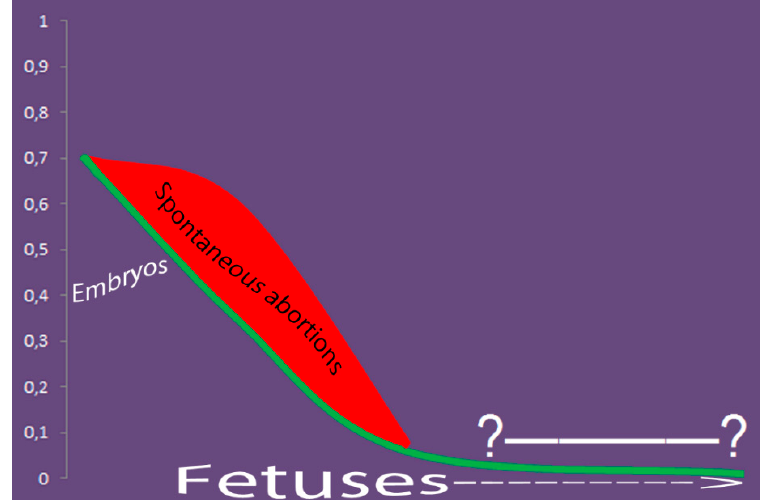
Figure 1. Profiling of decrease trend in somatic chromosomal mosaicism (SCM) rates throughout the prenatal development (according to [3,13,16,18,19,22–25,28,31,35]). Up to 70% of preimplantation embryos exhibit SCM/chromosome instability (CIN). About 25% of viable fetuses exhibit SCM/CIN (including chromosomal mosaicism confined to embryonic and extraembryonic tissues); in addition, up to 25% non-viable fetuses (spontaneous abortions) exhibit SCM at this development stage, as well. Later gestational periods are poorly addressed in terms of SCM. Nonetheless, cytogenetic analyses in the second and third trimester (prenatal diagnosis) show a significant decrease of SCM incidence as to cytogenetic studies of spontaneous and induced abortions. Therefore, one can suggest the existence of selective pressure against fetuses with SCM/CIN in early human ontogeny. The x-axis corresponds to the timeline from conception to birth, whereas the y-axis corresponds to the proportion of embryos/fetuses affected by SCM/CIN; the question marks fetal periods, which are poorly addressed in terms of SCM/CIN by molecular cytogenetic techniques.